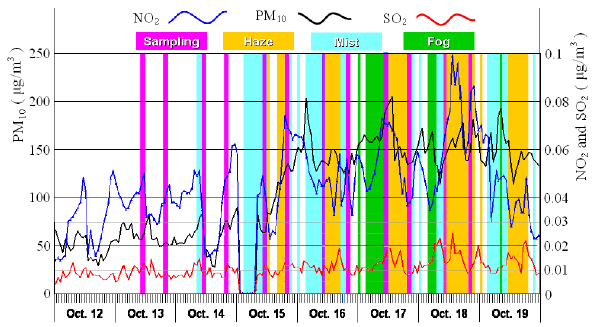
Fig. 8. Mass concentrations ( μ g/m 3 ) of air pollutants (PM 10 , SO 2 , and NO 2 ) on haze and non-haze days